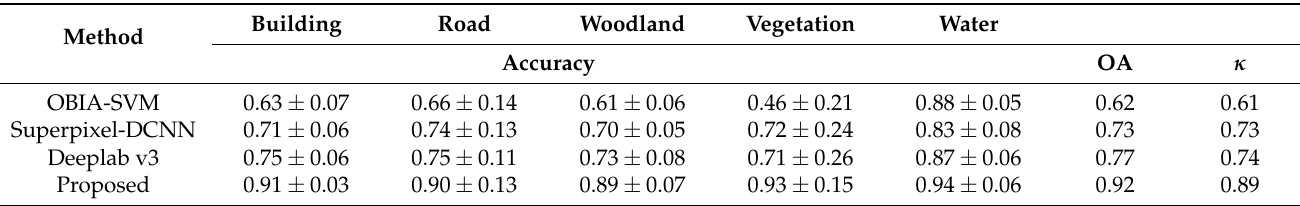
Table 4. Classification results on